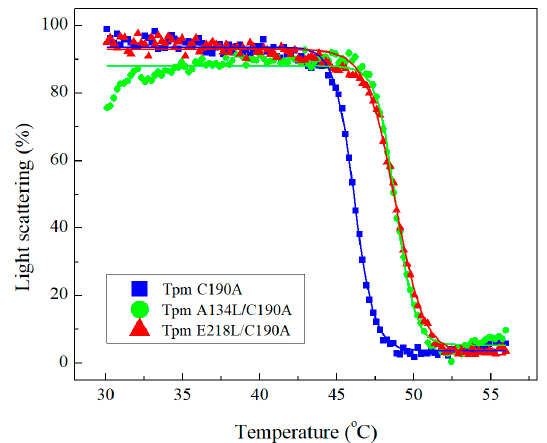
Figure 4. Normalized temperature dependencies of light scattering obtained for F-actin complexes with A134L / C190A, E218L / C190A, and C190A Tpm species. The standard experiment was done using 20 µ M F-actin stabilized by an equal molar amount of phalloidin and 10 µ M of Tpm in 30 mM Hepes-Na bu ff er containing 100 mM NaCl, pH 7.3. The decrease in light scattering reflects the dissociation of Tpm from F-actin.